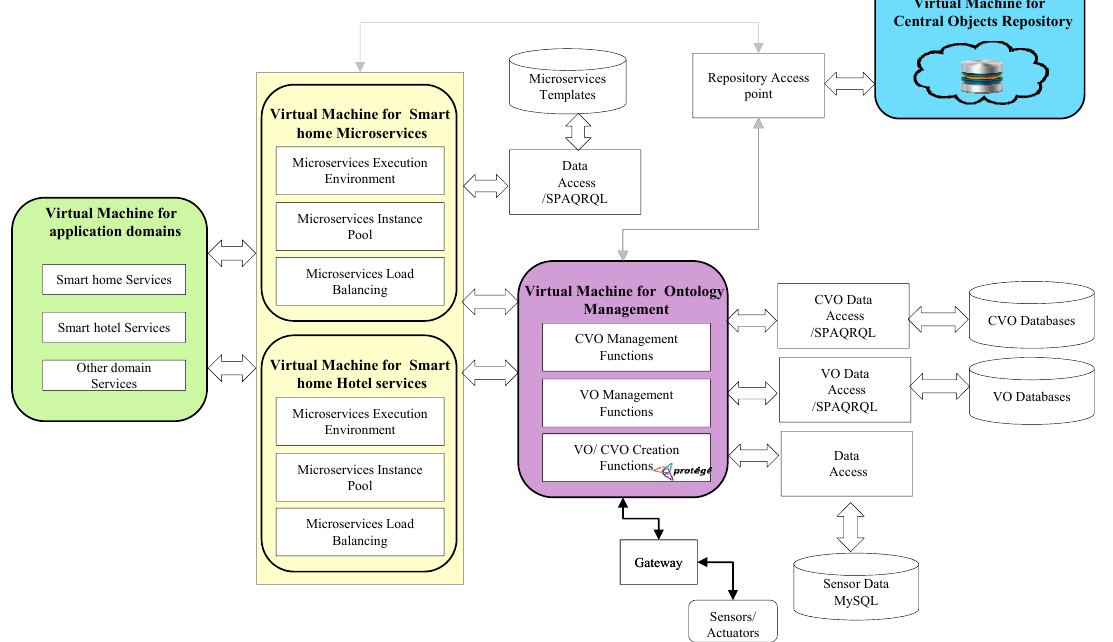
Figure 6. Prototype implementation model for the use case